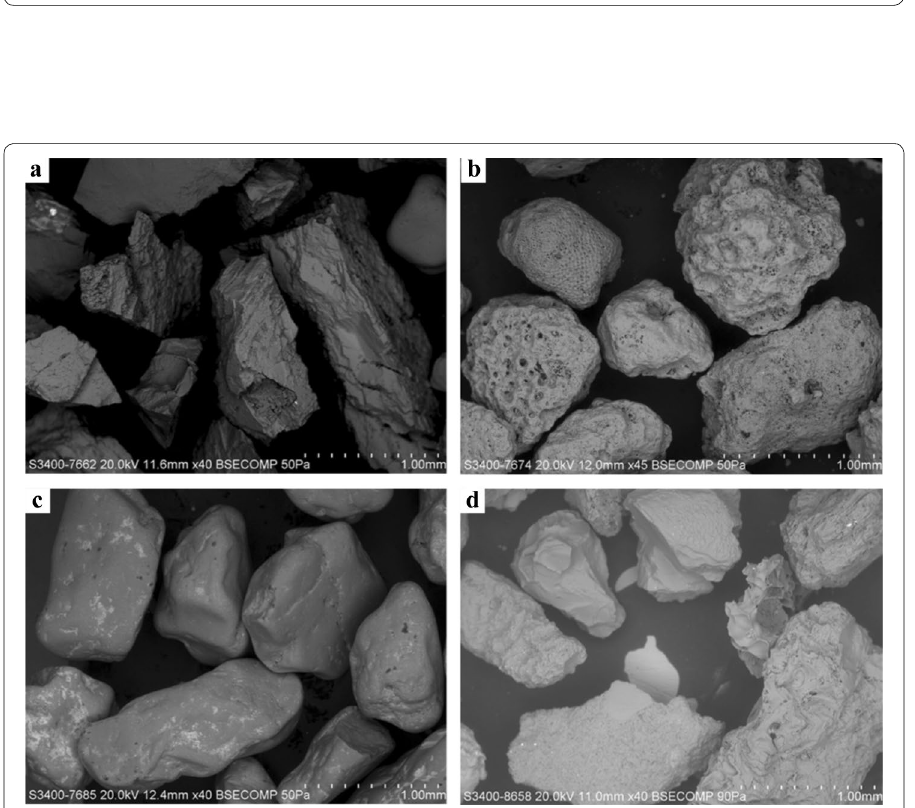
Fig. 2 Scanning electron microscope images for test materials with size of 0.6–1.18 mm: a completely decomposed granite; b carbonate sand; c Leighton Buzzard sand; d pumice